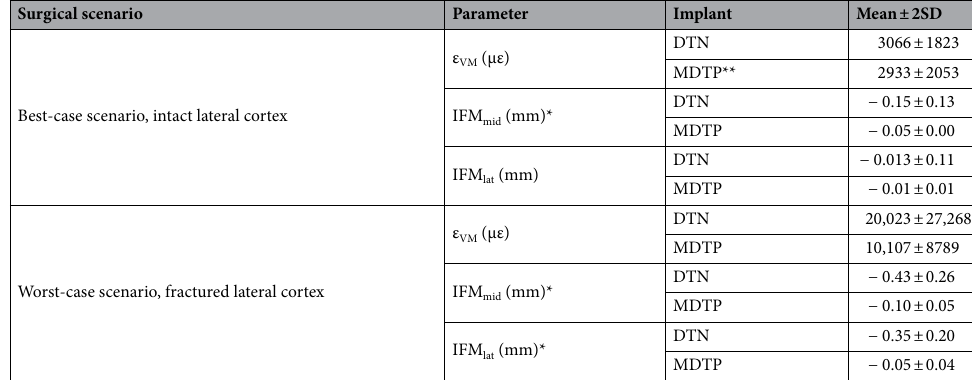
Table 2. Average Maximal Von Mises’ strain around the osteotomy (ε VM ) and interfragmentary movement (IFM) for all DTN (n = 8) and MDTP (n = 8) samples in a best and worst-case surgical outcome setting and a compressive load of 700 N. ε VM , average maximal Von Mises’ strain around the osteotomy; µε, micro-strain; IFM mid , interfragmentary movement across the osteotomy gap; IFM lat , interfragmentary movement across the lateral cortex; SD, standard deviation. *Significant difference at the 95% level between the DTN and MDTP implant groups. **n = 7, data from the MDTP-6 sample is missing due to corrupt data.